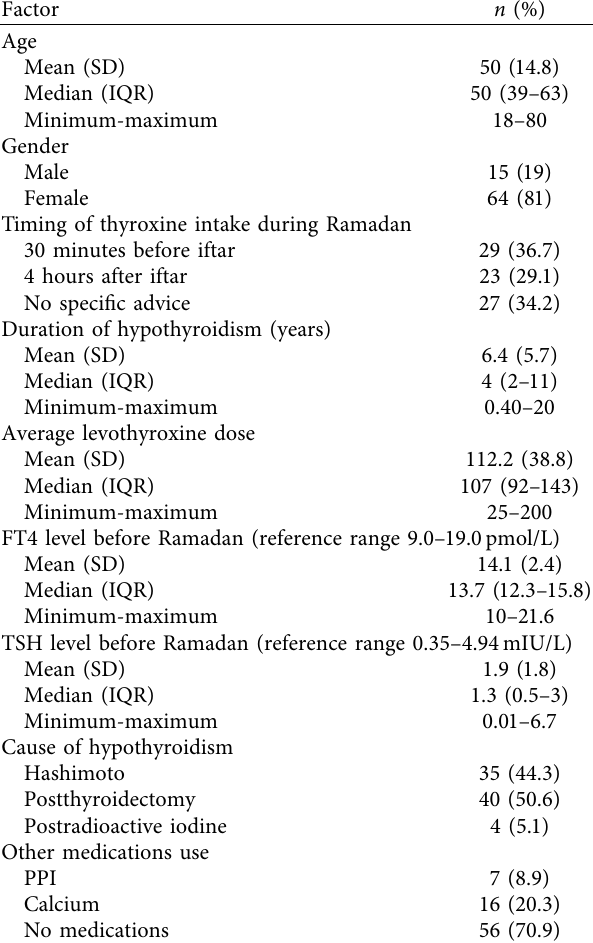
Table 1: Demographic and clinical characteristics of the